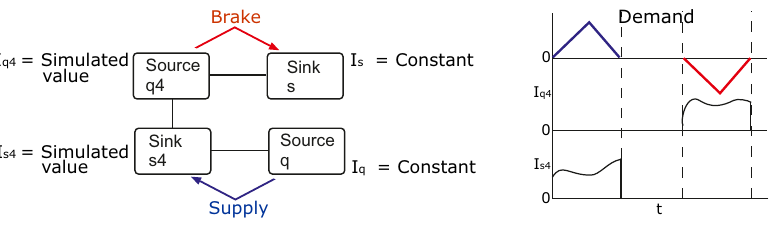
Figure 14. Emulation of motor/generator